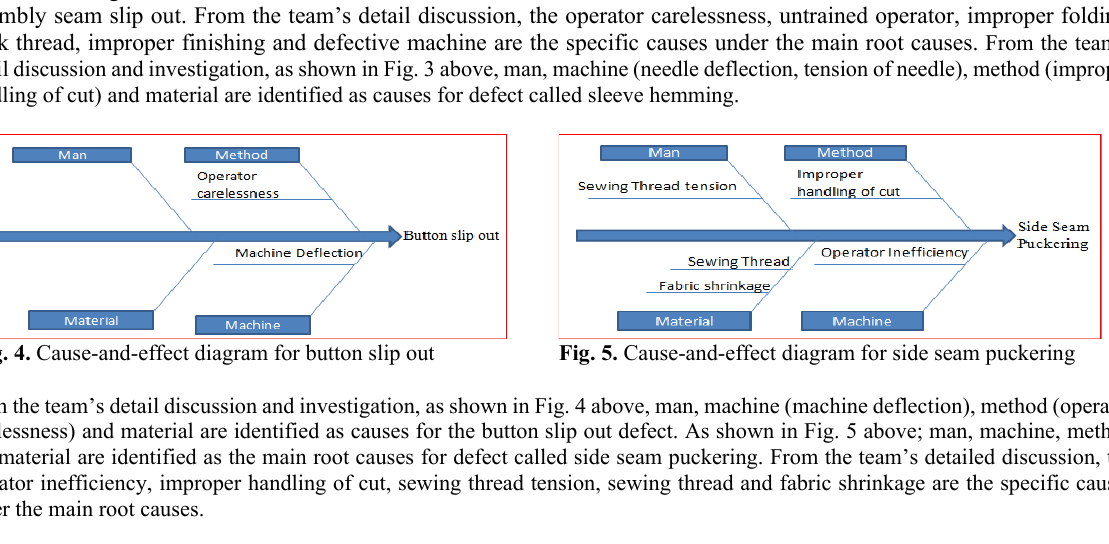
Fig. 2. Cause-and-effect diagram for cuff assembly seam slip out